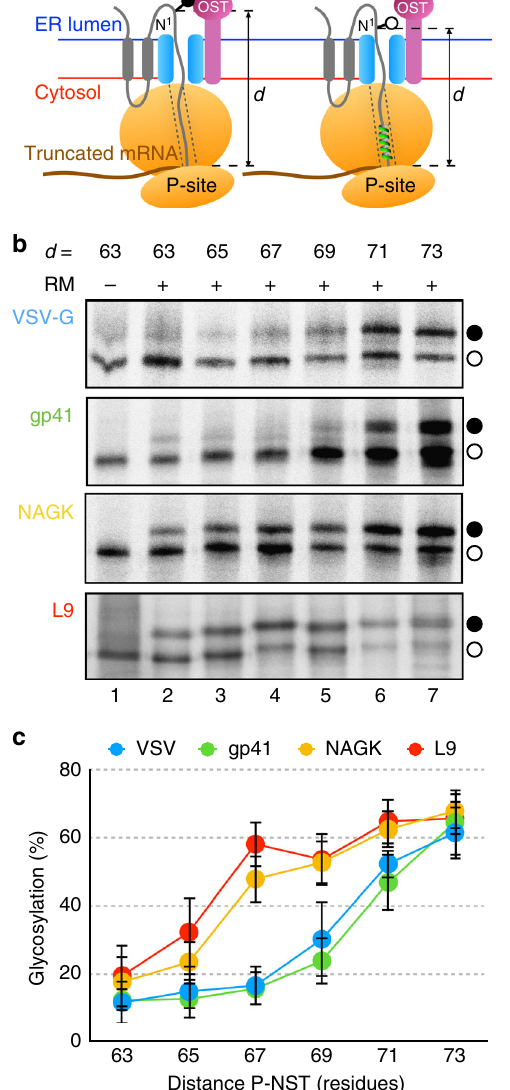
Fig. 1 Helices in the ribosome exit tunnel. a The model protein used in this study ( E. coli Lep) has two TM segments (gray) and a large C-terminal domain. Ribosome-bound truncated nascent chains of different lengths are generated by in vitro translation, in the presence of dog pancreas microsomes, of mRNAs lacking a stop codon (brown). The minimum number of residues required to span the distance between the ribosomal P- site and the active site of the OST ( d , distance P-NST) will depend on the compactness of the polypeptide region located inside the ribosome tunnel. Ribosome cartoon is not drawn to scale with respect to the length of the nascent polypeptide chain nor to the membrane thickness. b In vitro translation in the absence ( − ) and presence ( + ) of rough dog pancreas microsomes (RM) of truncated mRNAs of different lengths harboring the sequences encoding different helices: VSV-G TM segment (residues 463 – 482), gp41 TM segment (residues 684 – 705), NAGK helix (residues 5 – 26), and L9 helix (residues 45 – 67). The number of residues between the Asn residue in an Asn-Ser-Thr glycosylation acceptor site and the C- terminal end of the nascent chain are shown on top. Glycosylated and non- glycosylated molecules are indicated by black and white dots, respectively. c Glycosylation pro fi les for constructs of the indicated lengths harboring the different helical sequences. Error bars represent the mean ± SD; n ≥ 3. Source data are provided as a Source Data fi